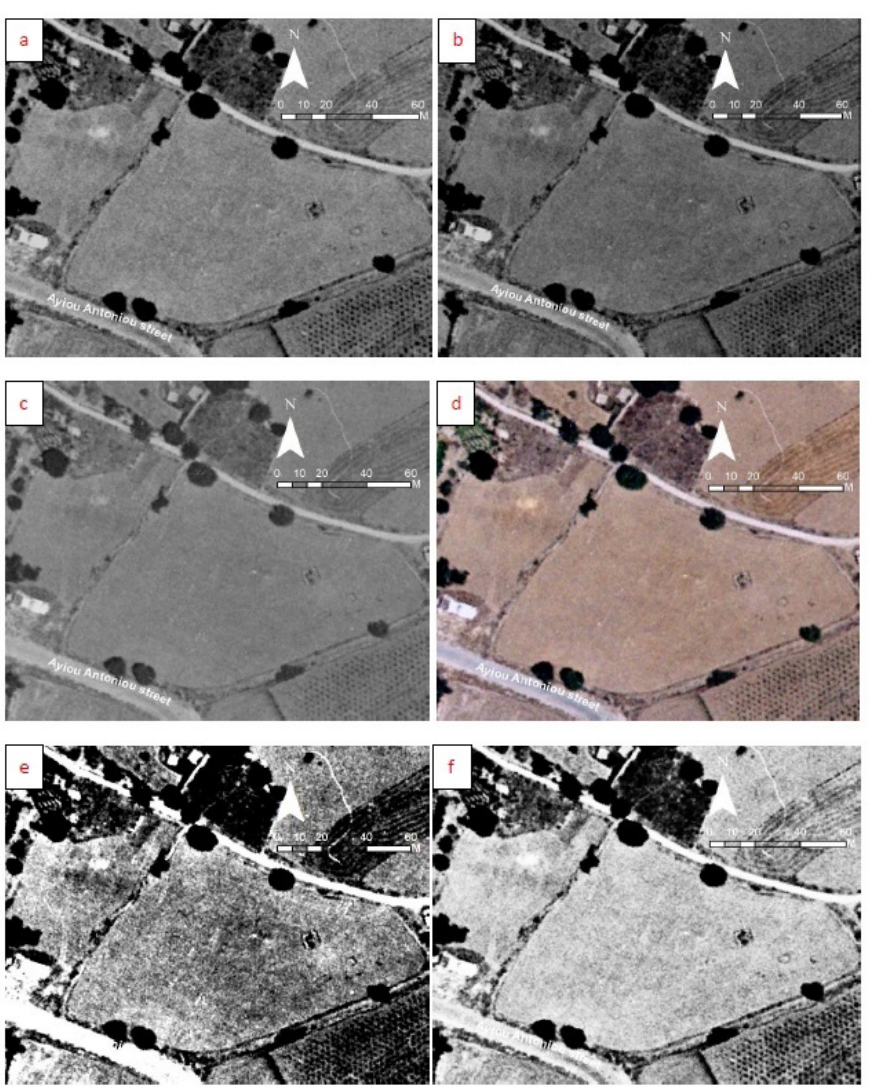
Figure 9: Archaeological proxies’ concentrations on the rectified 1968 aerial photograph: Band 1–3; RGB; histogram enhancement (a–c; d; e–f